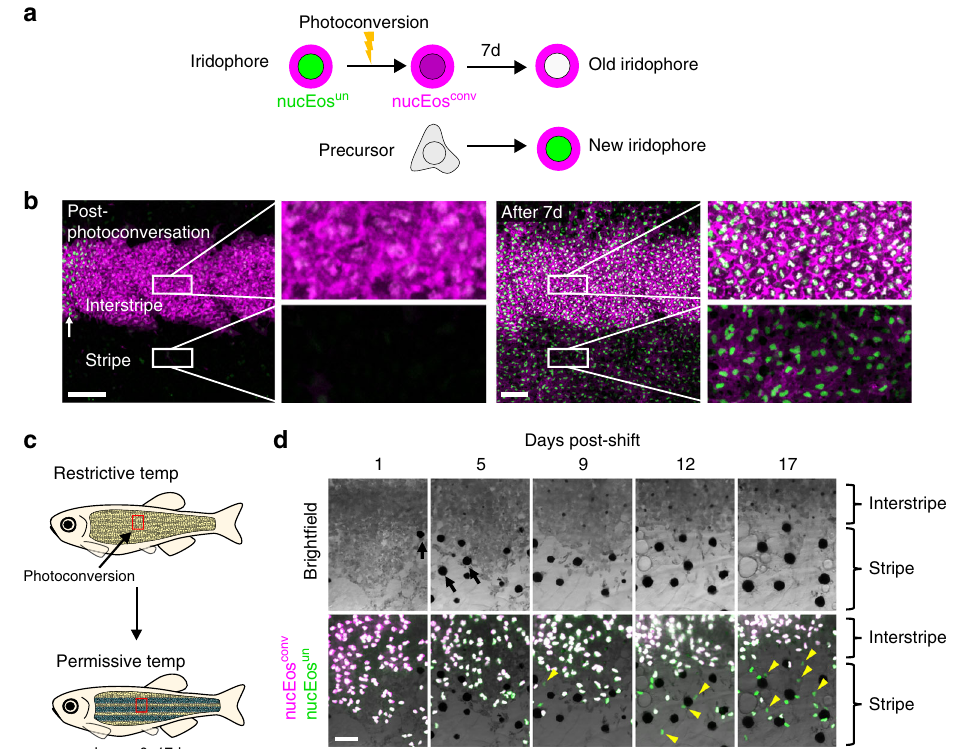
Fig. 2 Photoconversion experiments to test models of pattern development and remodeling. a Fish were generated to have iridophores expressing nuclear-localizing Eos (nucEos un , green) and a membrane-targeted mCherry (mem-Cherry, magenta) driven by regulatory elements of pnp4a . Following photoconversion of an iridophore population, the converted nuclei will appear magenta (nucEos con ). After 7 days, previously photoconverted nuclei will appear white (due to the combination of “ new ” green proteins and “ old ” magenta proteins), whereas nuclei of newly differentiated cells will appear green. b Tracking photoconverted iridophores in the interstripe revealed that stripe iridophores do not derive from the interstripe population. Following photoconversion of a region in the primary interstripe of a fi sh at 7.5 SSL, all nuclei appeared magenta (post-photoconversion), with surrounding mem- Cherry-labeled plasma membrane magenta-colored as well (left panel). After 7 days of additional development (8.6 SSL), at which time iridophores had populated the primary stripe, only nuclei with green signal were seen in the stripe zone, whereas interstripe nuclei were primarily white (right panel). Higher magni fi cation images of boxed regions, show interstripe iridophores that retained nucEos conv , while also acquiring new nucEos un (making their nuclei white; upper inset, right panel). Stripe iridophores, by contrast, lacked nucEos conv and expressed only nucEos un (making their nuclei green; lower inset, right panel). Example shown is representative of a total of eight individual fi sh examined. c Use of a temperature-sensitive mitfa vc7 allele to examine the effect of conditional melanophore development on iridophore pattern remodeling. For this experiment, iridophores were labeled only with a nuclear- localizing Eos (nucEos un , green; nucEos conv , magenta); after photoconversion nuclei appear magenta, or white as new nucEos un was produced. d Bright fi eld (upper) and fl uorescence superimposed on bright fi eld (lower) following photoconversion and shift to permissive temperature to drive onset of melanophore differentiation. Iridophores labeled by nucEos expression were photoconverted at the beginning of the experiment and followed over 17 days to distinguish newly differentiating iridophores (green) from previously differentiated iridophores (white). As melanophores differentiated (see yellow arrows in top panel), the region of dense morphology iridophores receded dorsally. This change was accompanied by differentiation of new iridophores having green nuclei (see yellow arrowheads in bottom panel) in the newly forming stripe. Example shown is representative of a total of 12 individuals across two independent experiments. Scale bars, b 100 µ m, d 50 µ